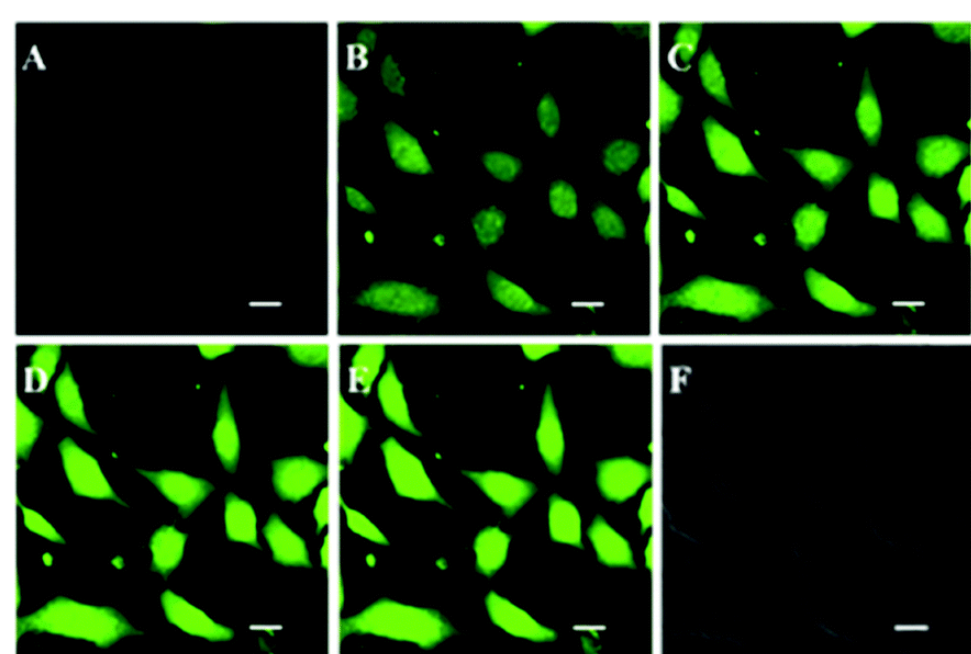
Figure 20. Confocal laser scanning microscopy images of A549 cancer cells after incubation with the AIE polymer containing TPP (40 μg mL −1 ) and dichlorofluorescein diacetate (10 μM) under white light irradiation for ( A ) 0 min, ( B ) 2 min, ( C ) 4 min, ( D ) 6 min, and ( E ) 8 min. ( F ) is the bright-field image. λ ex = 488 nm, λ em = 505 –525 nm. The scale bar is 20 μm. Reproduced from reference [150] with permission from the Royal Society of Chemistry.